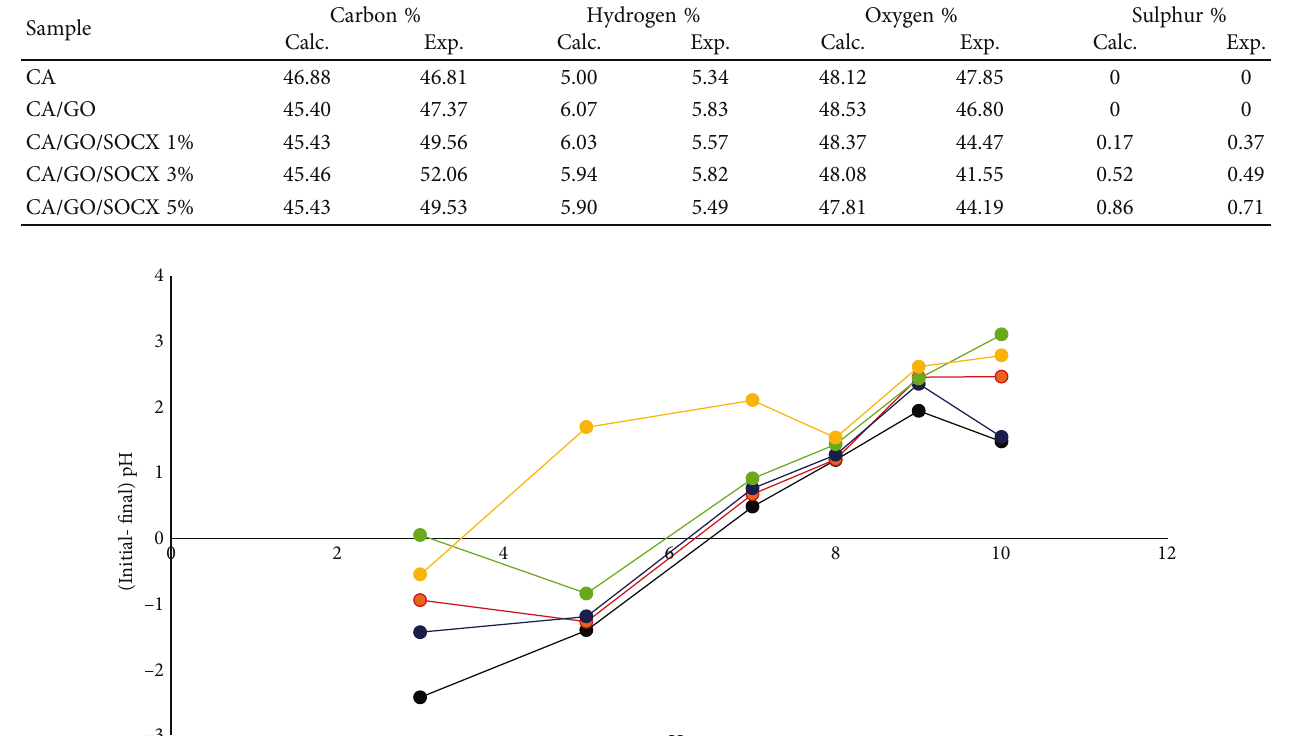
Table 1: CHNS elemental analysis of CA, GO functionalized CA nano fi ber, and GO and p-SOCX functionalized CA nano fi ber at di ff erent amount of p-SOCX (1%,3%, and 5%).